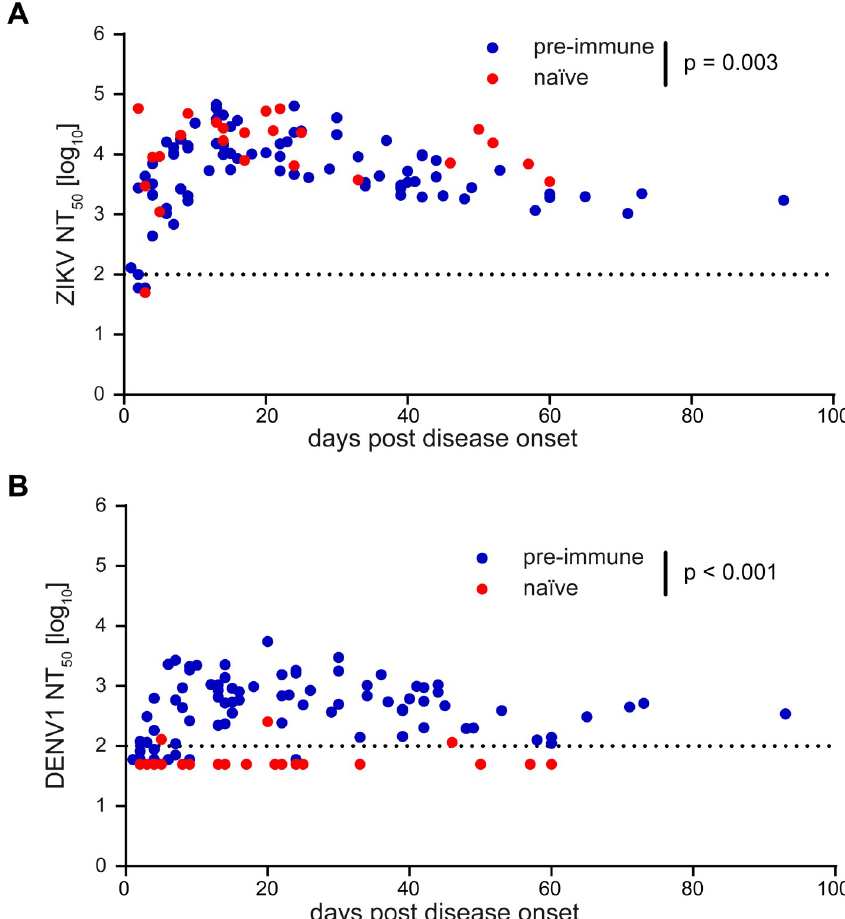
Fig 11. Zika and dengue virus neutralization tests using single serum samples from Zika cases. (A) Zika virus and (B) dengue virus NT 50 titers from individual serum samples were plotted against days after disease onset. Data points represent mean NT 50 titers from at least three independent experiments. Color code as in Fig 10. Dotted lines indicate the cut-off of each assay. The significance of differences between the extents of na ï ve and pre-immune antibody responses were calculated based on the maxima reached, applying a general linear model as described in Methods. p- values are indicated in the graphs. ZIKV, Zika virus; DENV1, dengue virus serotype 1.